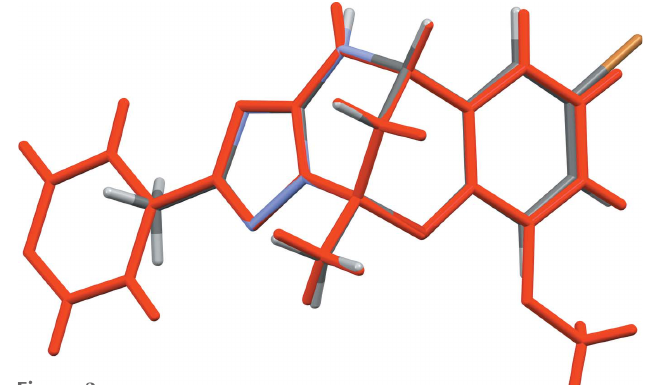
Figure 3 A view of the structural overlap of molecules I and II (in red), having an r.m.s. deviation of 0.005 A˚ ( Mercury ; Macrae et al. ,